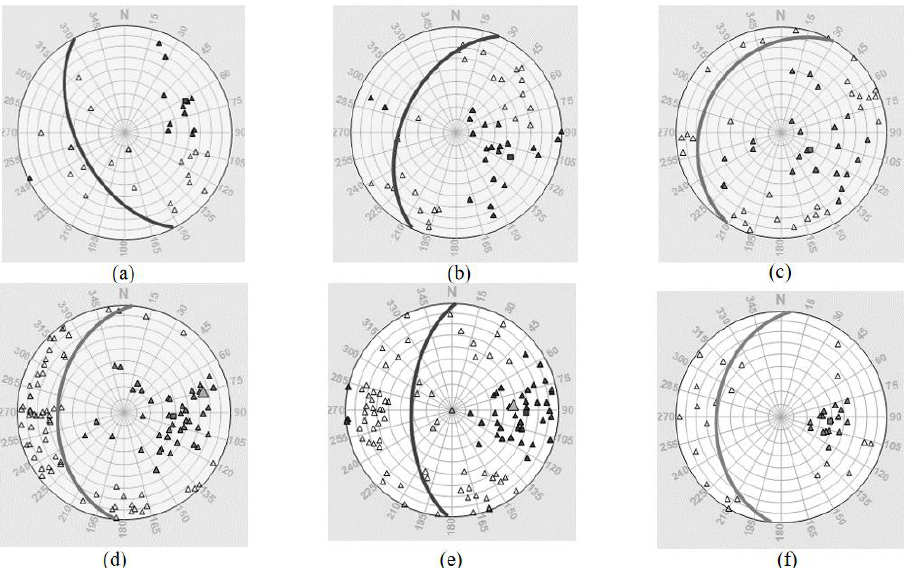
Figure 4. Stereographic projection of the occurrence of dominant joint groups at each measurement